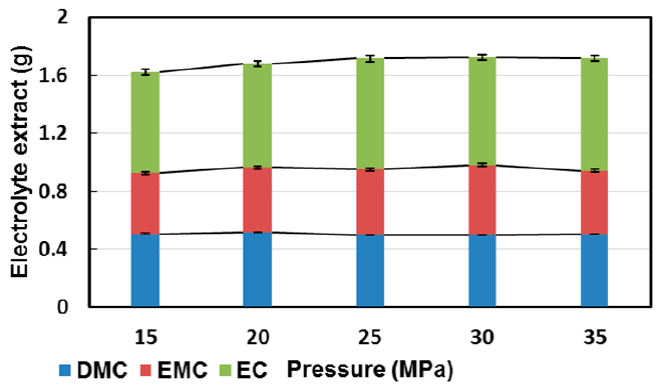
Figure 11. Compositions of the extracts corresponding to values obtained by gas chromatography—flame ionization detector (GC-FID) measurements. Green, top: EC; crimson, middle: EMC; blue, bottom: DMC [164].